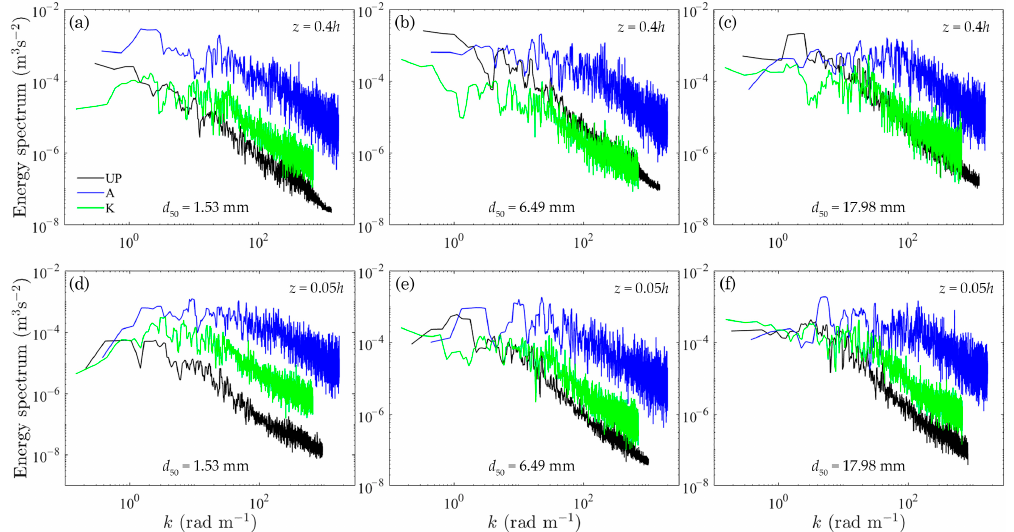
Figure 17. Energy spectra at the measuring points A (blue lines) and K (green lines) at z = 0.4 h for ( a ) Run 1, ( b ) Run 2, ( c ) Run 3 and at z = 0.05 h for ( d ) Run 1, ( e ) Run 2, ( f ) Run 3, respectively. The black lines refer to the energy spectra of the approaching flow.